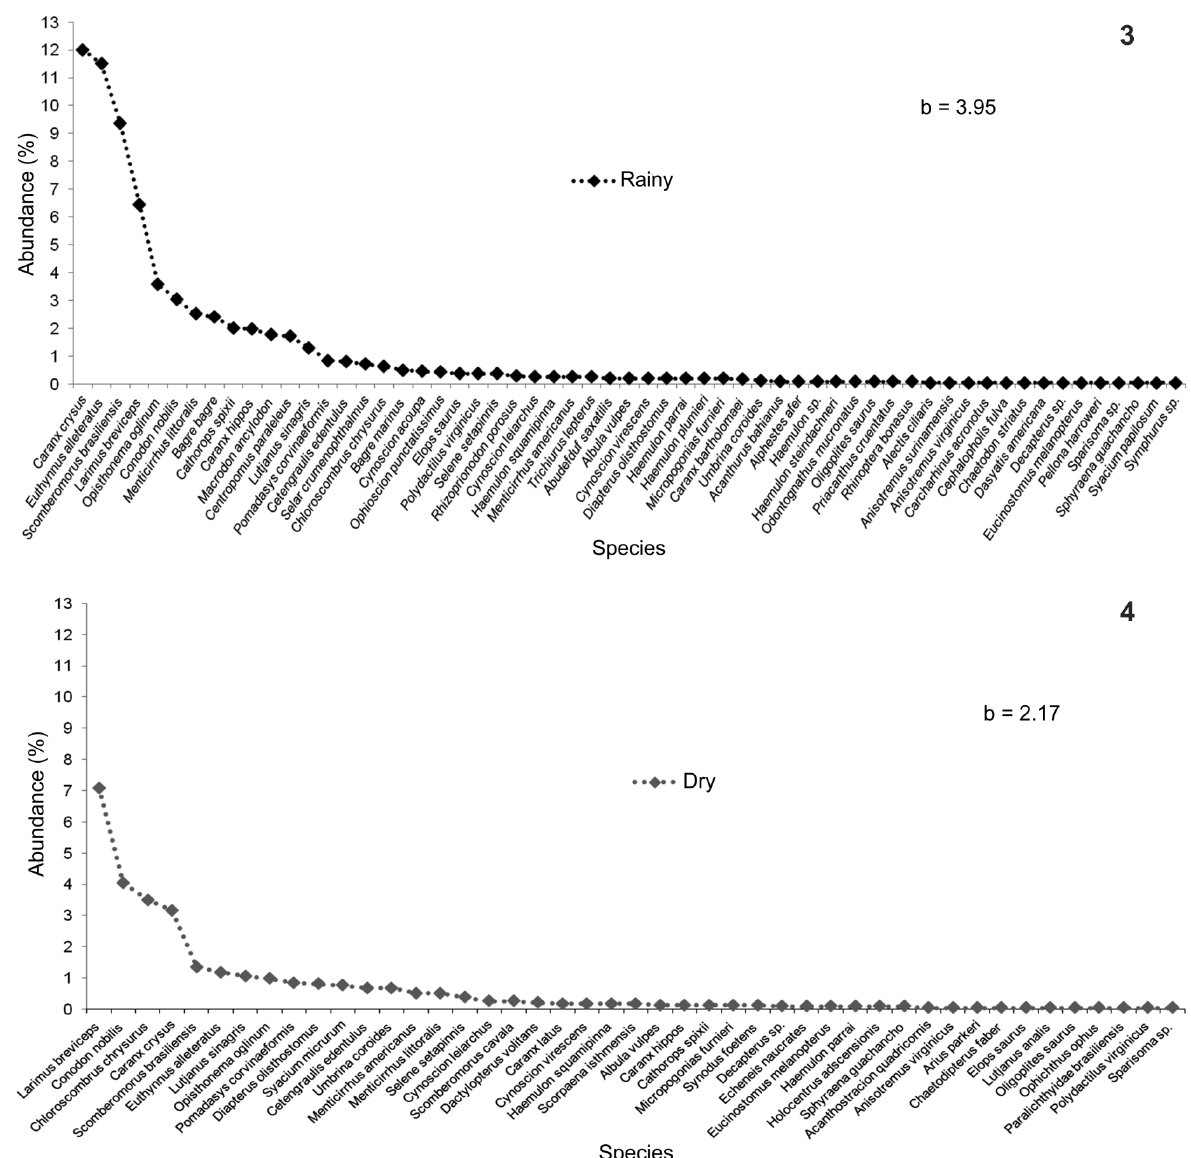
Figures 3-4. Whittaker plot of fishes from Alagoas coast sampled during the rainy season ( 3 ) and the dry season ( 4 ).